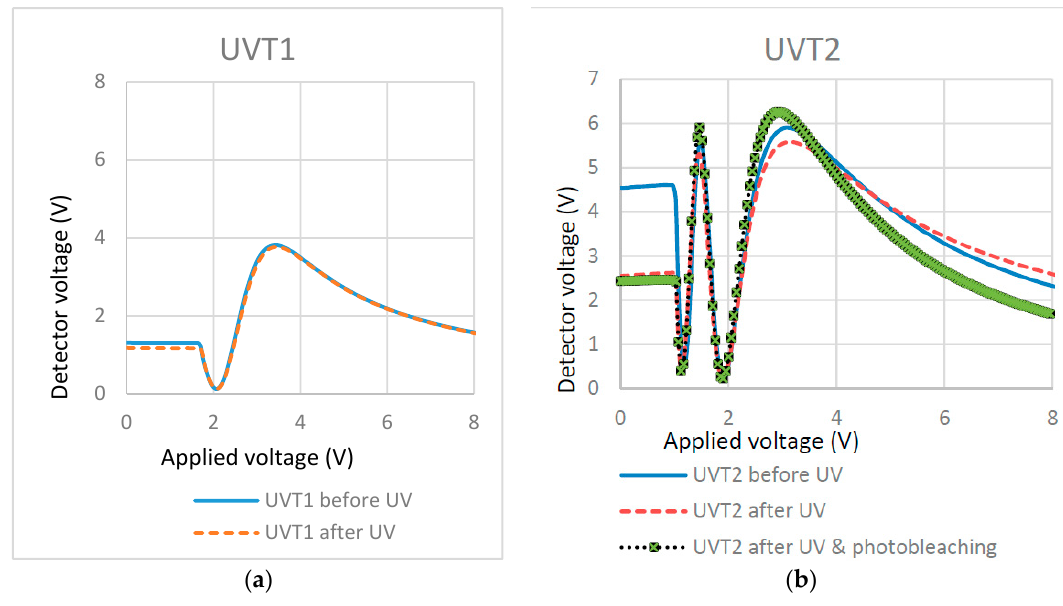
Figure 9. T/V curves of cells cured at different temperatures: ( a ) 22 °C and ( b ) 80 °C.